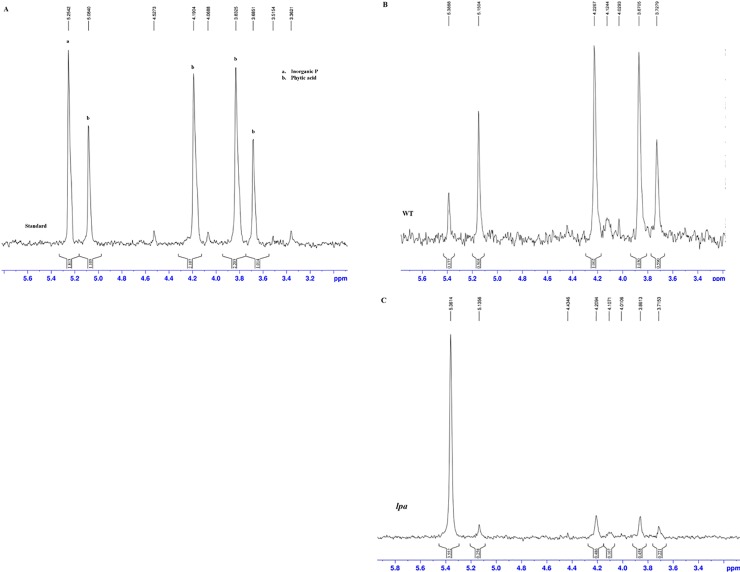
31P NMR spectrum of standard, Ilpum (WT), and the mutant, Sanggol (lpa) (A) Reference standard peaks. (B) Wild ‘WT’ (C) lpa ‘Mutant’.